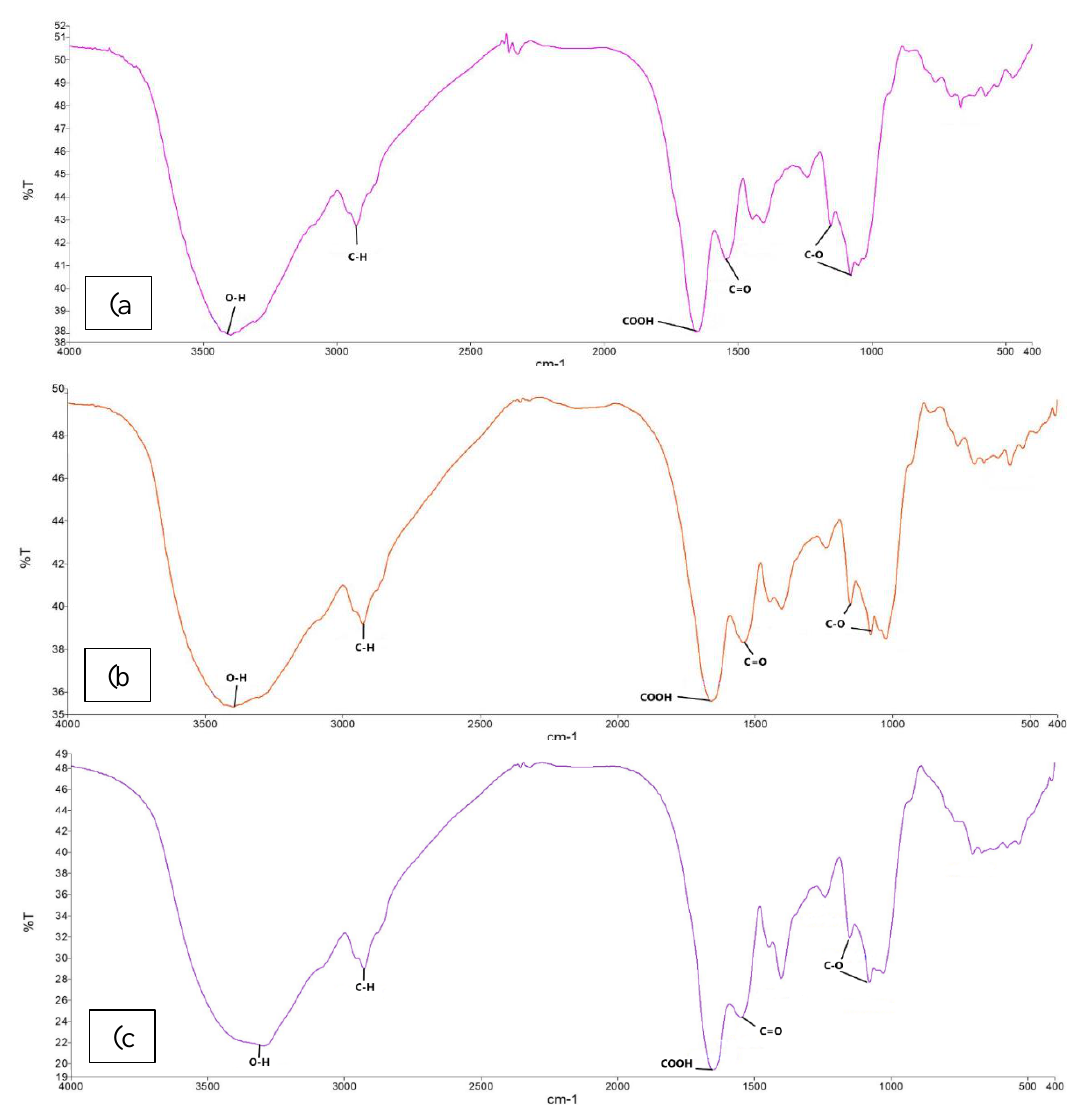
Figure 2. FTIR result of ( a ) red, ( b ) green, and ( c ) red lentil extract.